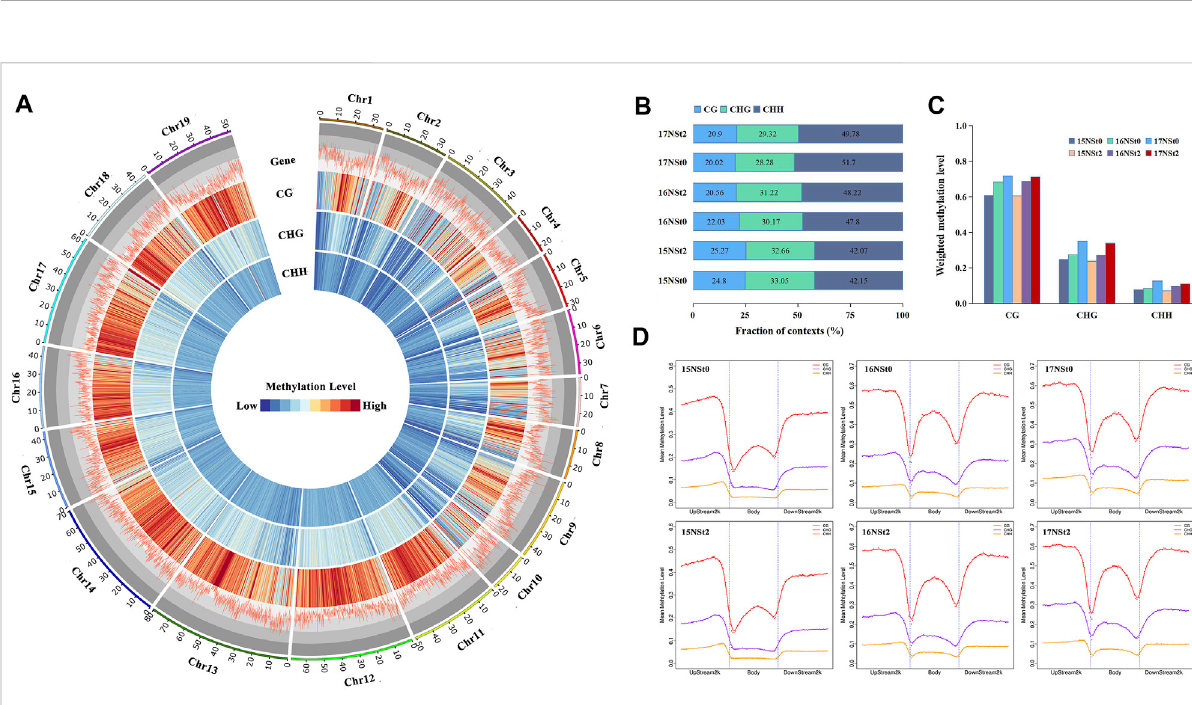
FIGURE 3 DNA methylation landscape of the winter rapeseed NS. (A) , Genome-wide pro fi les of CG, CHG and CHH DNA methylation across the chromosomes of winter rapeseed: gene density and methylation levels of CG, CHG and CHH sequence contexts in the control and freezing treatment samples, from outer to inner ring. 1-Mb window was used for calculating the gene density or methylation levels; (B) , Proportion of CG, CHG and CHH contexts in the total number of methylation sites of winter rapeseed samples under control and freezing treatment; (C) , Weighted methylation levels of CG, CHG and CHH contexts of winter rapeseed under control and freezing treatment; (D) , Regional methylation levels in three sequence contexts of winter rapeseed across gene-body, upstream 2 k and downstream 2 k regions in samples under control and freezing